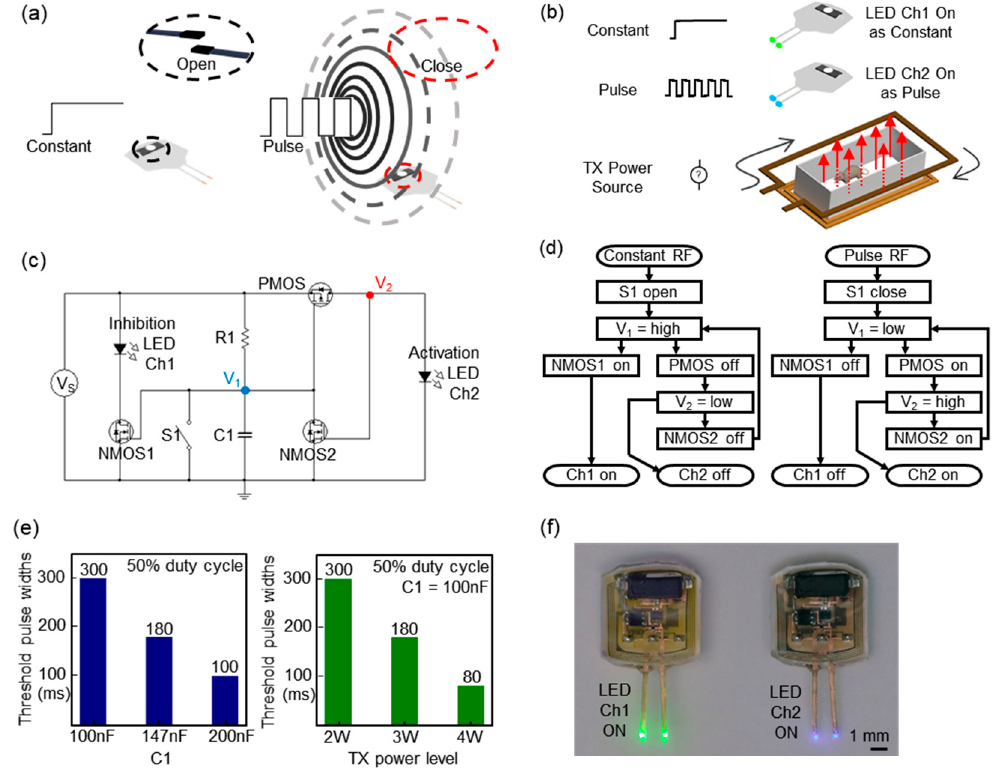
Figure 3. Demonstration of an advanced operational mode and magnet-free operation to expand the function and its characteristics. ( a ) Illustration of a mechanism by which a train of pulse signals induces an alternating magnetic field. ( b ) Schematic illustration of a magnet-free operational mode: inhibition and stimulation of neural activity. ( c ) Circuit diagram of a dual channel device that o ff ers an advanced magnet-free operational mode: inhibition and stimulation of neural activity. Here, a dual channel device automatically activates a channel in response to signals from a remotely located wireless TX system. R1 = 20 k Ω and the reed switch is denoted by S1. ( d ) Flowchart that depicts an actuation mechanism enabled by a pulse signal. ( e ) Plot of the measurements of the threshold pulse widths required for the switching operation as a function of a capacitor, C1, and TX power. ( f ) Pictures of an advanced operational mode and magnet-free